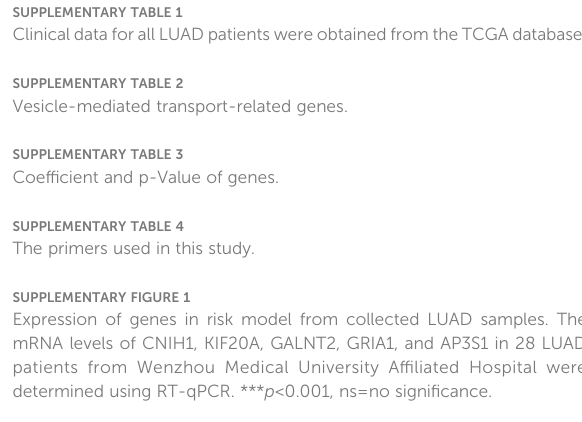
SUPPLEMENTARY TABLE 2 Vesicle-mediated transport-related genes. SUPPLEMENTARY TABLE 3 Coef fi cient and p-Value of genes. SUPPLEMENTARY TABLE 4 The primers used in this study. SUPPLEMENTARY FIGURE 1 Expression of genes in risk model from collected LUAD samples. The mRNA levels of CNIH1, KIF20A, GALNT2, GRIA1, and AP3S1 in 28 LUAD patients from Wenzhou Medical University Af fi liated Hospital